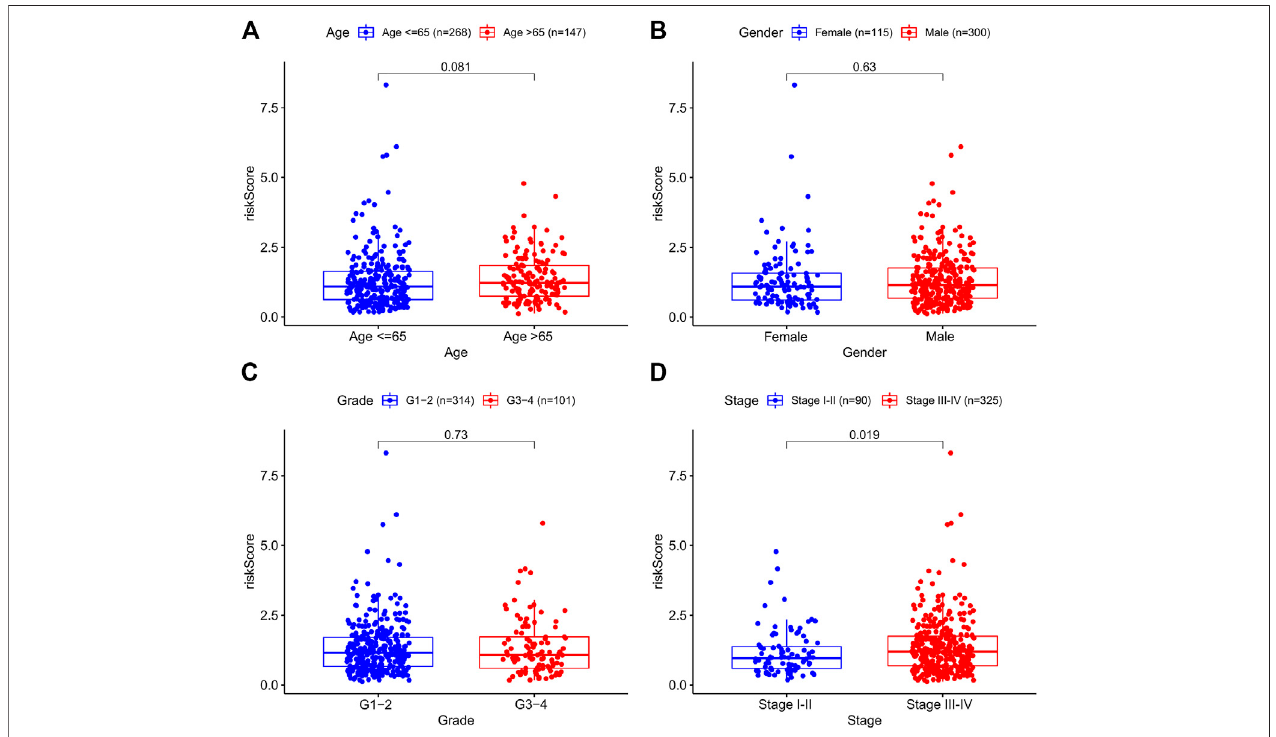
FIGURE 3 | The correlations between the risk model and clinical factors. (A) Age. (B) Gender. (C) Grade. (D) Stage.